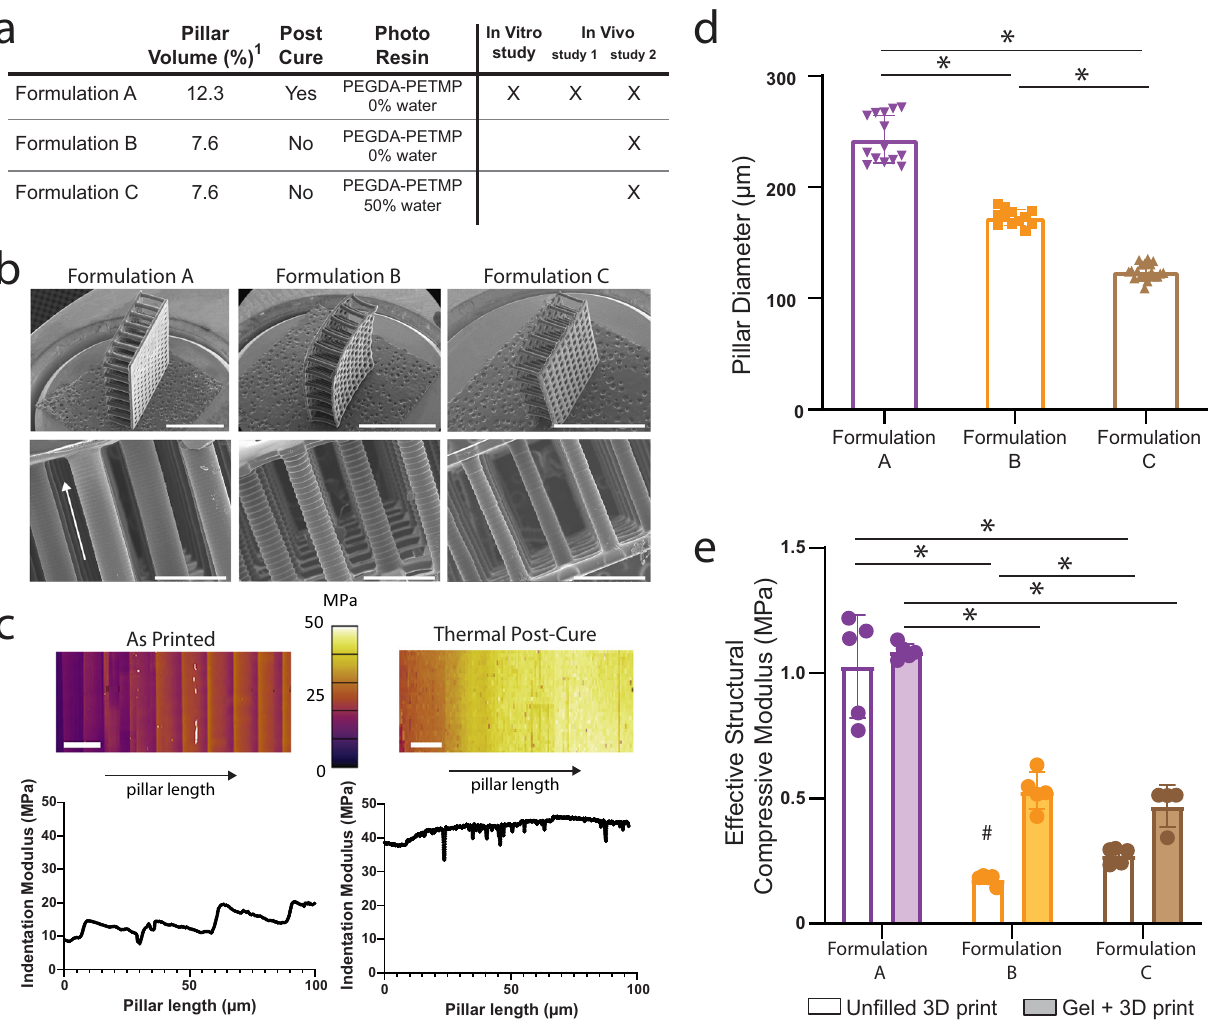
Fig. 3 Characterization of the different gel + 3D print formulations used in this study. a Table showing the pillar volume ( 1 pillar volume % is based on CAD design), post-cure conditions, and photo resin used for the 3D print for each formulation. b SEM images of all three scaffold designs. Scale bar on top row of images is 3 mm and higher-resolution images (bottom row) scale bar represents 500 μ m. (arrow represents pillar length). c 3D printed structure evaluated via AFM showing fl uctuations in mechanical properties down the length of the pillar due to printing process (left, as printed) and the improved mechanical properties and reduction in variance after thermal post-cure process (right, thermal post-cure). Scale bars represent 20 µm. d Pillar diameter measured via SEM showing all three formulations have signi fi cantly different pillar diameters once printed. * denotes signi fi cant differences ( p < 0.05; Kruskal – Wallis test). e Effective structural compressive modulus of the un fi lled 3D print and gel + 3D print composite using Formulation A, Formulation B, and Formulation C (un fi lled 3D print represented with empty fi ll bars, Gel + 3D print represented with solid fi ll bars). Results show Formulation A was signi fi cantly different than Formulation B and C, but no differences in compressive modulus were seen between Formulations B and C when fi lled with the cartilage mimetic hydrogel. *denotes signi fi cant differences ( p < 0.05; one-way ANOVA, Tukey ’ s HSD post hoc) between formulations, and # denotes signi fi cant difference ( p < 0.05; t -test) between the fi lled and un fi lled 3D print. Data represent mean ± standard deviation (error conditions at day one. Higher-resolution images demonstrate that the encapsulated rMSCs had a similar round morphology within the hydrogel formulation includes ChS. There was positive staining the cartilage-mimetic hydrogel in both conditions. After 9 weeks, at 3 and 9 weeks in regions around the cells, which were devoid of cells maintained uniform distribution throughout both conditions and displayed a round chondrogenic phenotype, with some deposition of pericellular matrix (PCM) in both conditions. These observations indicate that the 3D structure retains the round cell morphology within the soft mimetic hydrogel. To assess the chondrogenic differentiation of the rMSCs in the gel only or gel + 3D print conditions, Safranin-O/Fast Green to the gel only. Positive PEG staining after nine weeks in both conditions indicated that the soft hydrogel had not completely types II and X were performed after one day, three weeks, and nine weeks of culture (Fig. 5a). Safranin-O/Fast Green staining